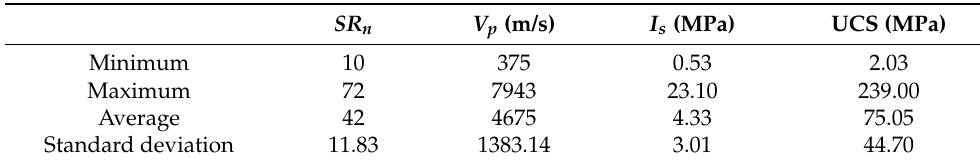
Table 1. Brief descriptive statistics of the